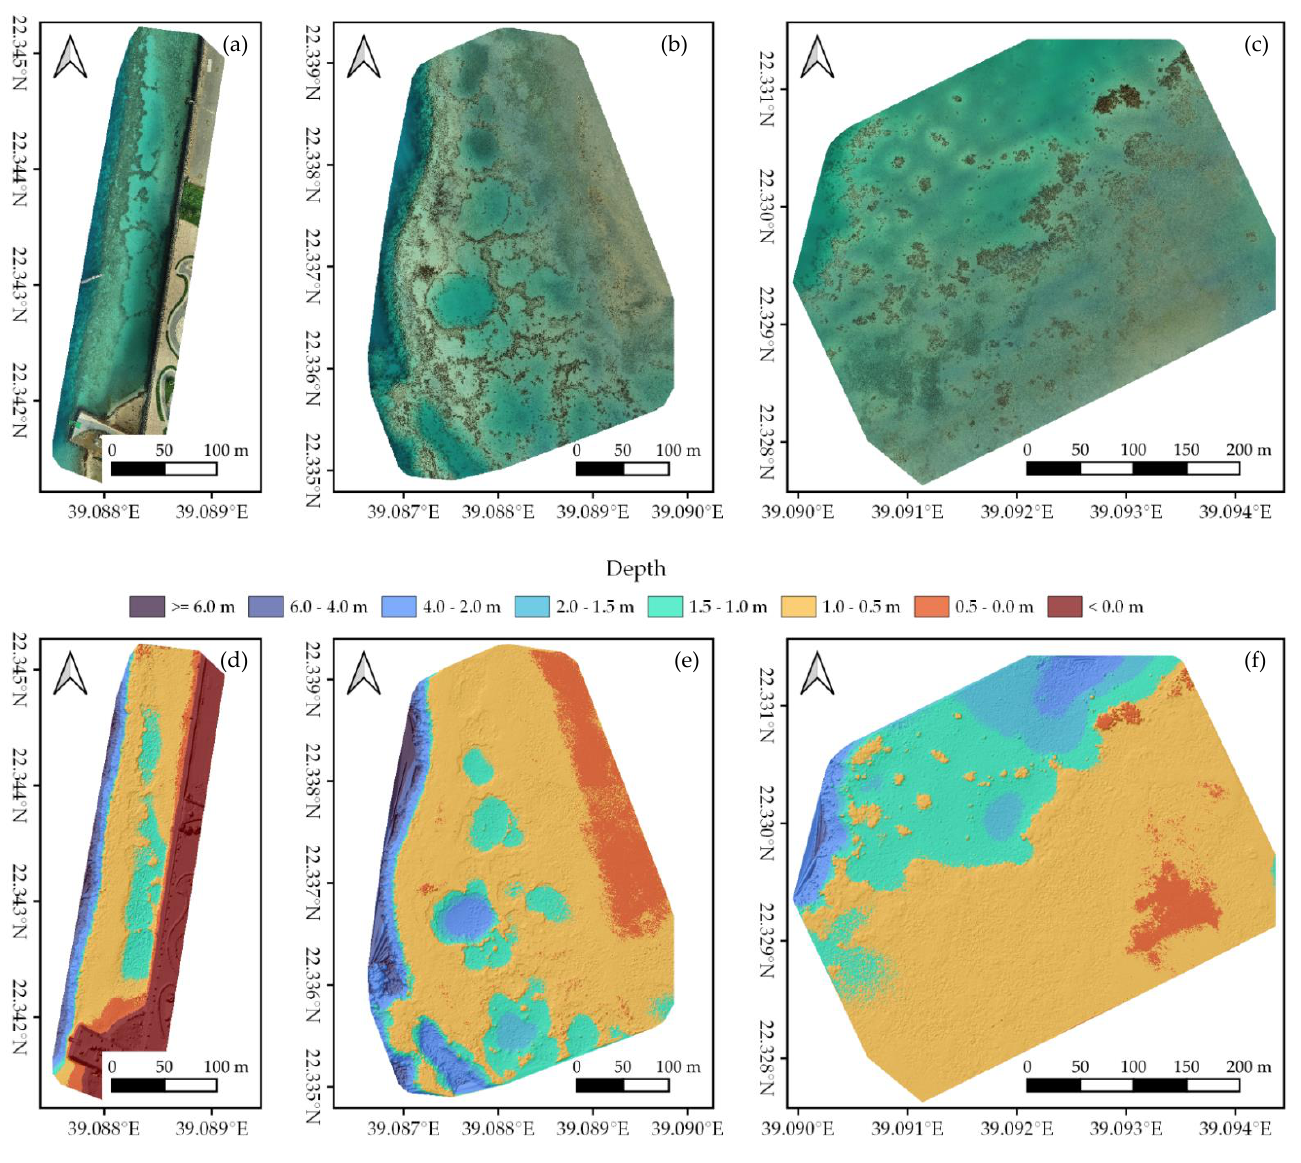
Figure 2. Structure-from-Motion outputs of ( a , d ) Area 1, ( b , e ) Area 2, and ( c , f ) Area 3 (Figure 1). ( a – c ) The generated orthomosaics; ( d – f ) the corresponding Digital Elevation Models, displayed as orthometric depth.